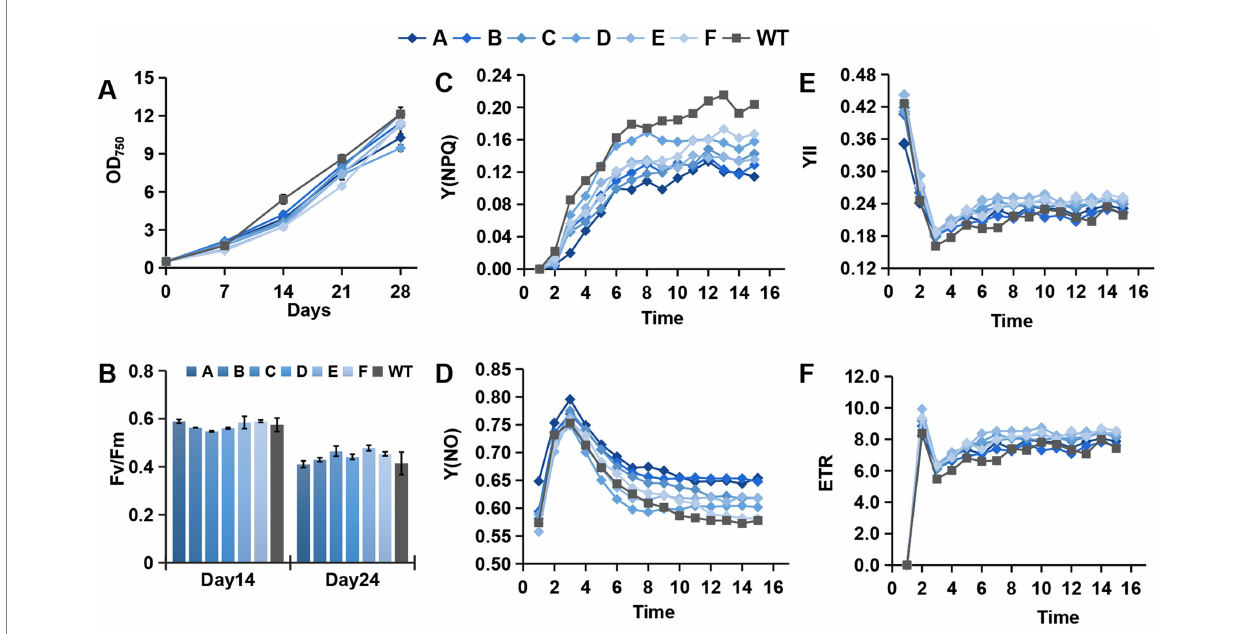
FIGURE 3 Growth and photosynthetic parameters of different mutants and the WT. (A–F) Growth curve, Fv/Fm, Y(NPQ), Y(NO), YII, and ETR of the photosystem.